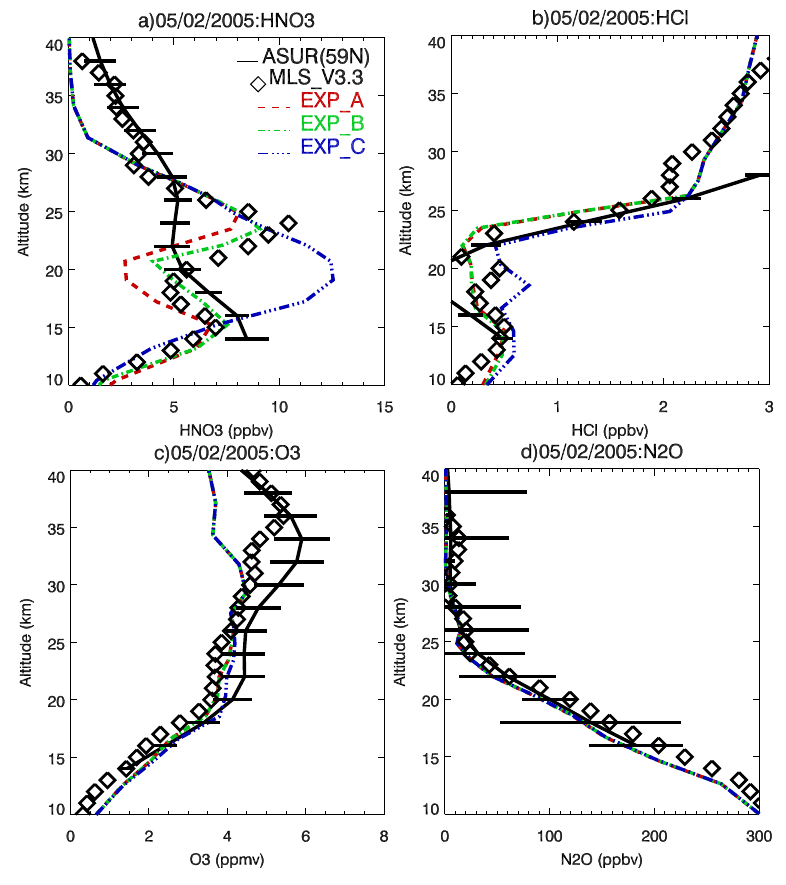
Fig. 2. HNO 3 , HCl, O 3 and N 2 O from ASUR observations and model simulations using equilibrium (EXP A), DLAPSE (EXP B) PSC schemes and without denitrification (EXP C) for 5 February